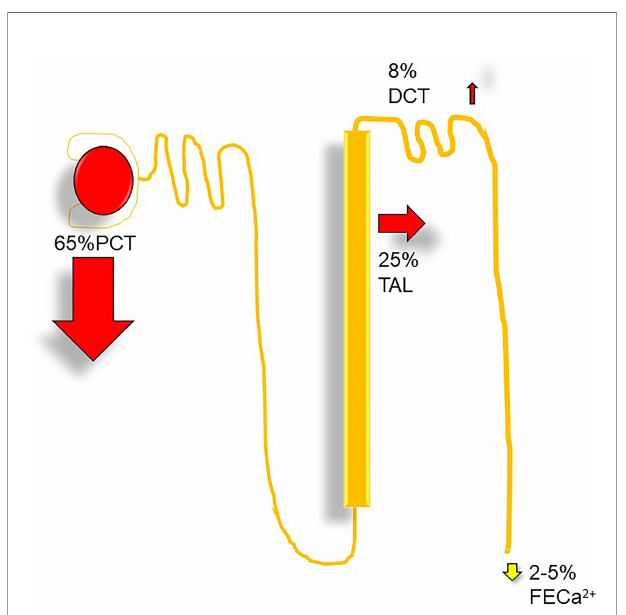
FIGURE 3 | Nephron calcium transport: DCT, distal convoluted tubule, Ca 2+ , fractional excretion of calcium (%); PCT, proximal convoluted tubule; TAL, thick ascending limb.